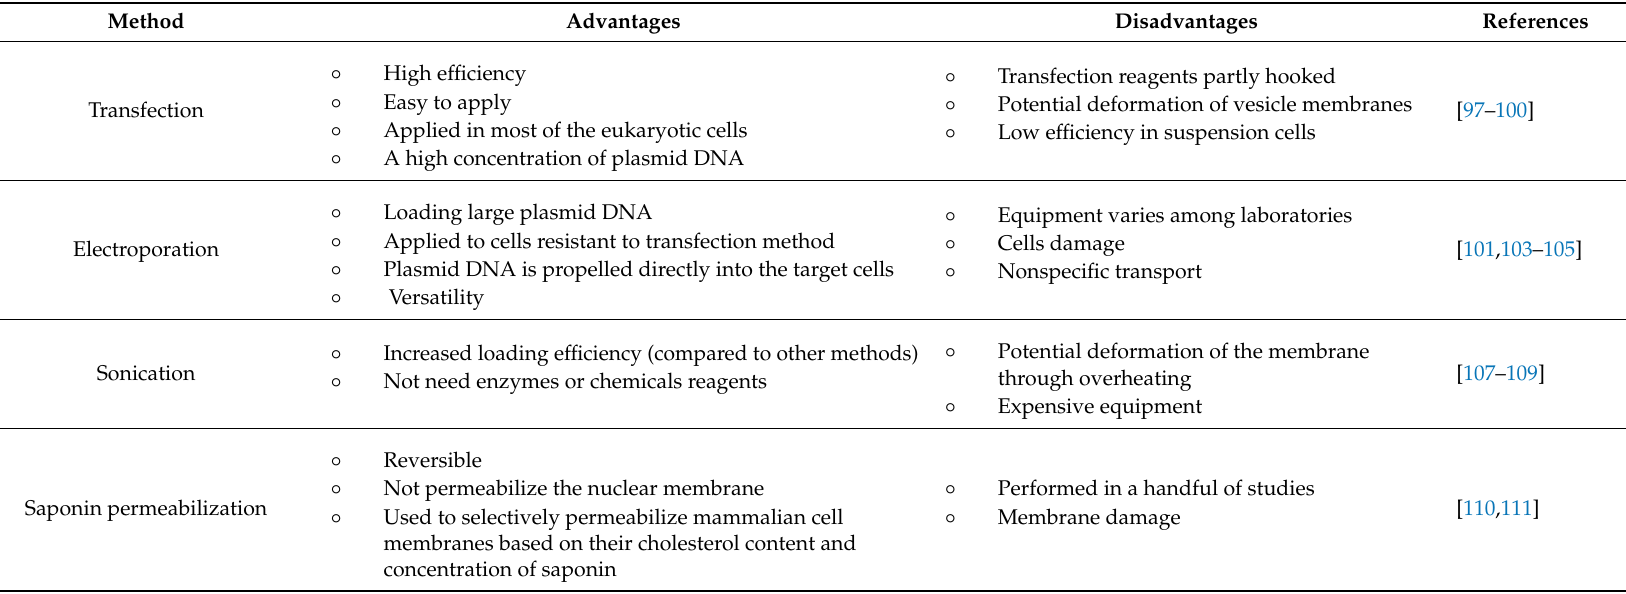
Table 1. Comparison of the exogenous methods for plasmid DNA loading into extracellular vesicles